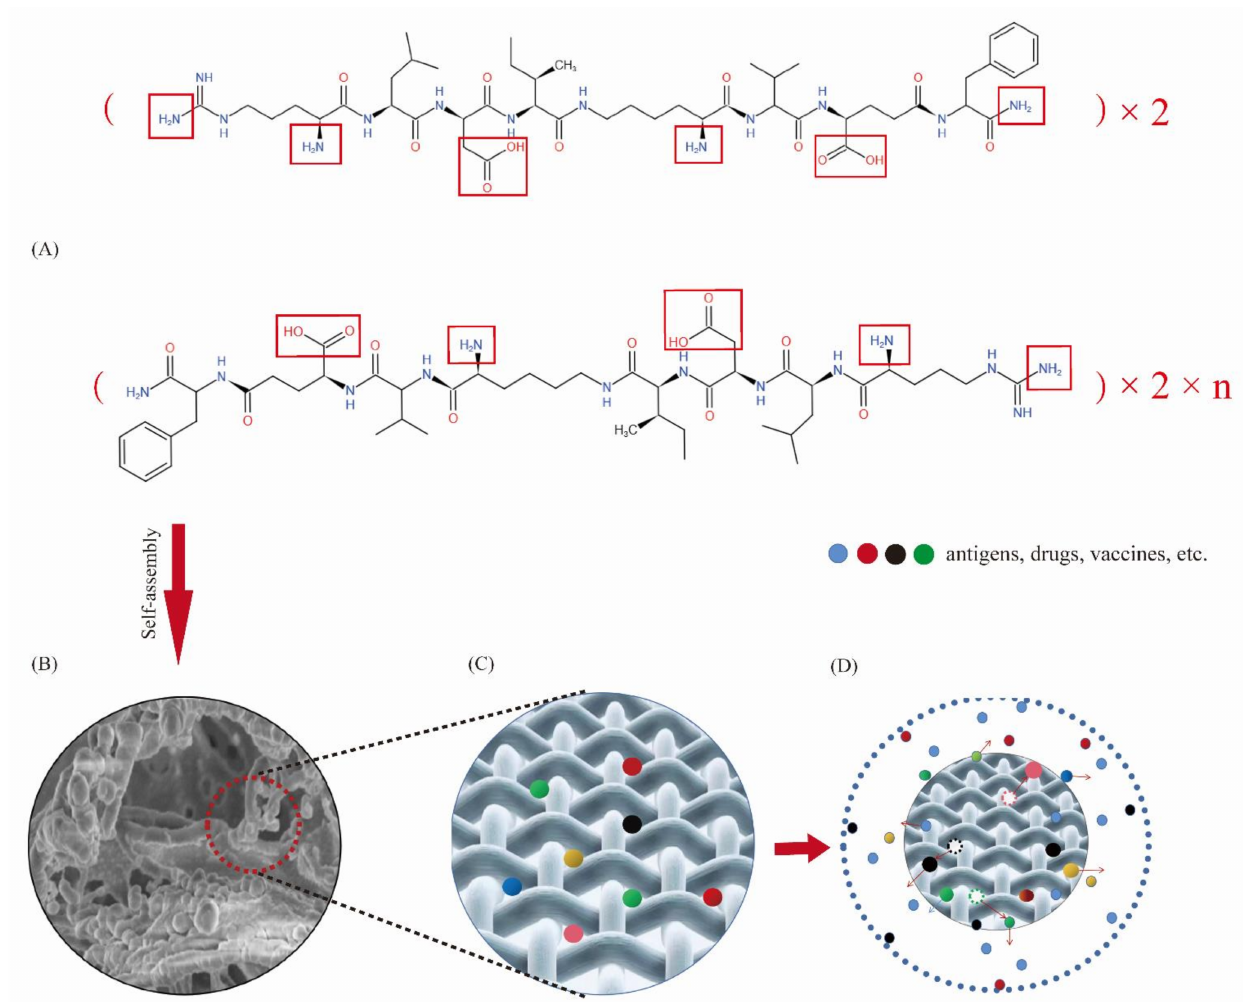
Figure 14. Structure diagram and reasonable model diagram of DRF3. ( A ) Structure diagram of DRF3; ( B ) Three-dimensional nanoscaffold structure model of self-assembled peptide hydrogel DRF3; ( C ) Peptide hydrogel DRF3 is loaded with antigens, drugs or vaccines; ( D ) Peptide hydrogel DRF3 controlled release antigens, drugs or vaccines, while recruiting immune